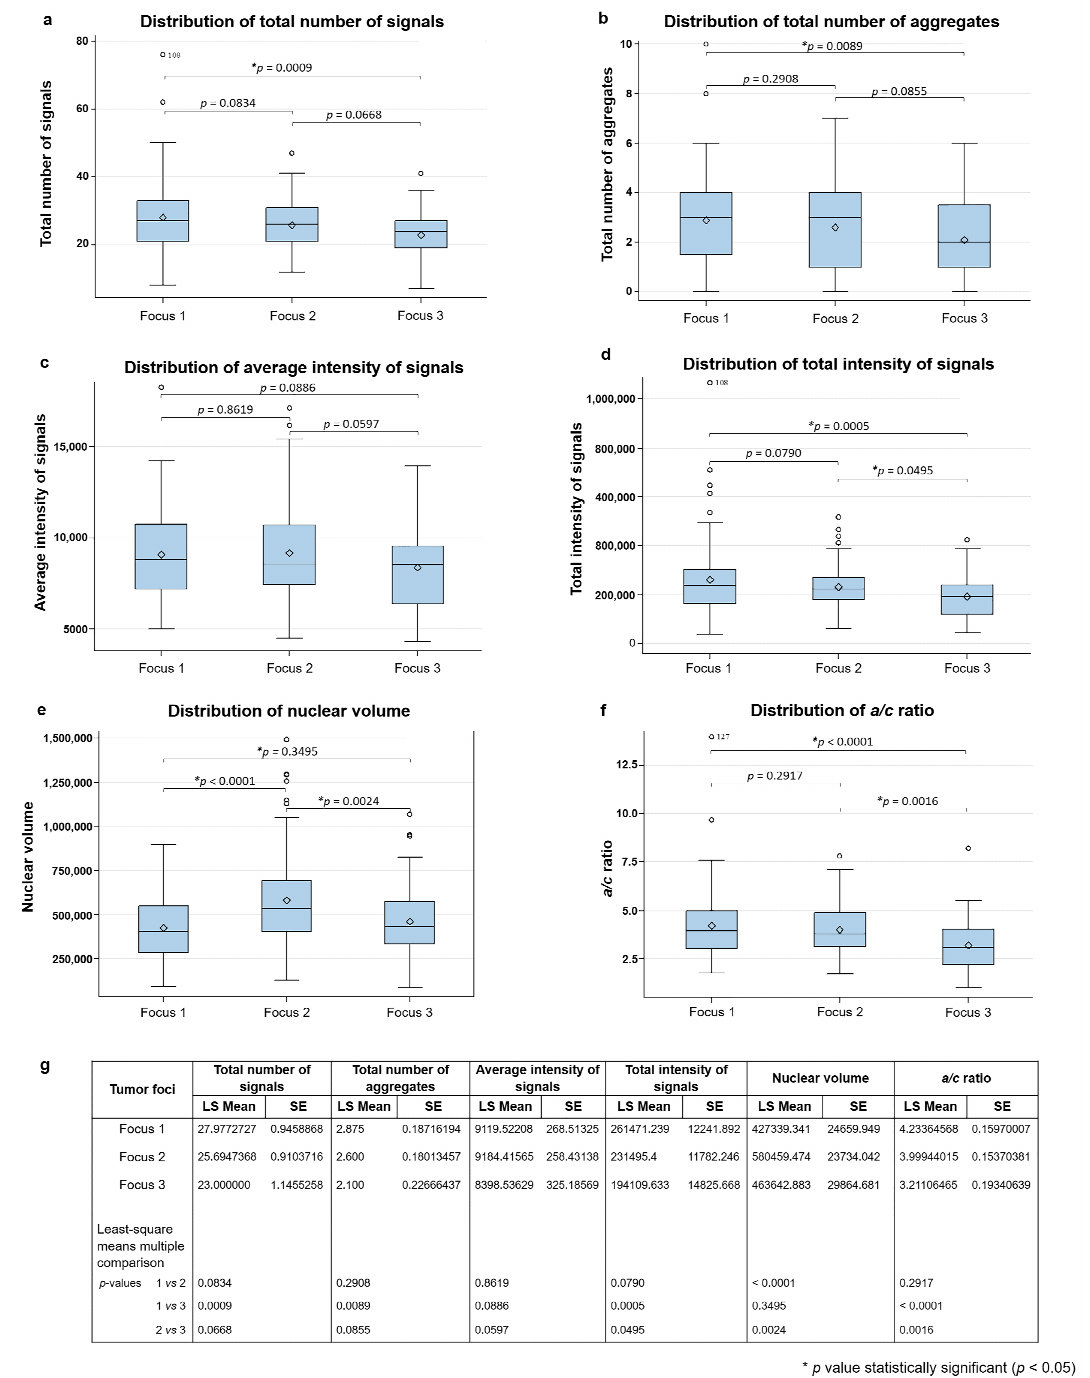
Figure 2. Histogram of the distribution of total number of telomere signals ( a ); total number of telomeric aggregates (TA) ( b ); av-erage intensity of signals ( c ); total intensity of signals ( d ); nuclear volume ( e ) and a/c ratio ( f ). In ( g ), we show the p -values for each comparison made in pairs. LS Mean: least square means. SE: standard error. * p <